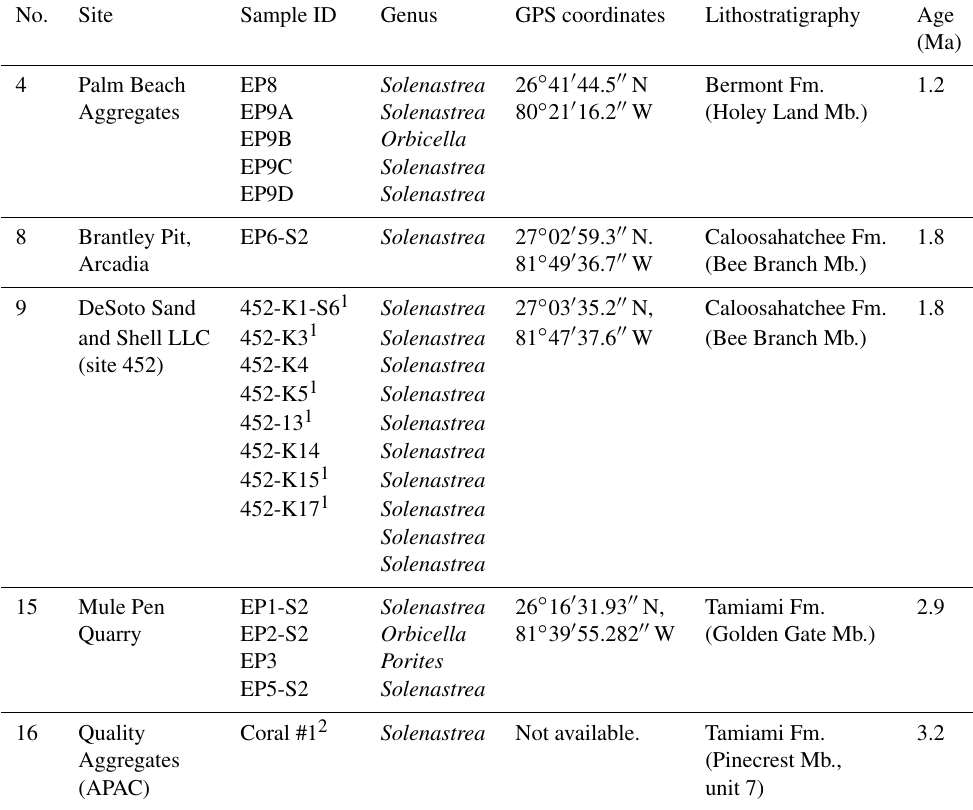
Table 1. Sampling sites in southern Florida. The numbering follows that given by Brachert et al. (2014). No. Site Sample ID Genus GPS coordinates Lithostratigraphy Age Palm Beach EP8 Solenastrea 26 ◦ 41 (cid:48) 44.5 (cid:48)(cid:48) N Bermont Fm.